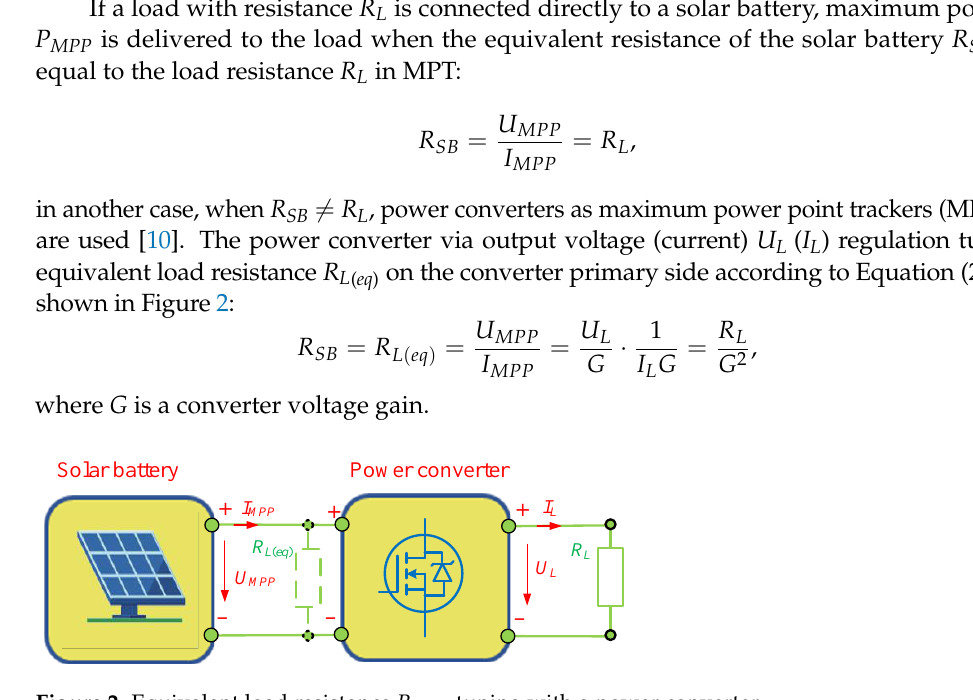
Figure 1. A family of power curves for different solar insolation powers: ( a ) as functions of voltage U , P = f ( U ); ( b ) as functions of current I , P = f ( I ). For voltage curves, MPP coordinates U MPP are defined by the open circuit solar battery voltage U OC which is almost constant and belongs to the narrow range U MPP ∈ [0.72 · U OC ; 0.76 · U OC ] that slightly depends on solar insolation power P SI . The current MPP co-ordinate I MPP is influenced by the short-circuit current I SC , I MPP ∈ [0.9 · I SC ; 0.93 · I SC ]. However, is proportional to P SI [9].